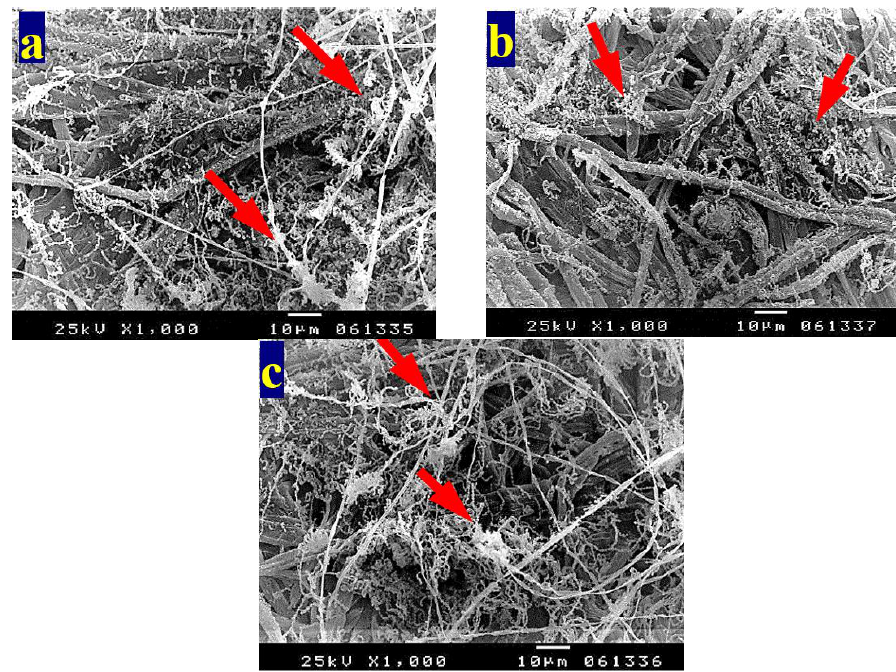
Figure 3. SEM images of E. camaldulensis WB pulp paper manufactured without HeOE additives and inoculated with A. terreus : ( a ), ( b ) without additives, where arrows refer to dense growth of fungal mycelia and fungal spores on sample fibers; and ( c ) with 10% DMSO where arrows refer also to huge agglomeration of fungal mycelia on the surface of the sample fibers.